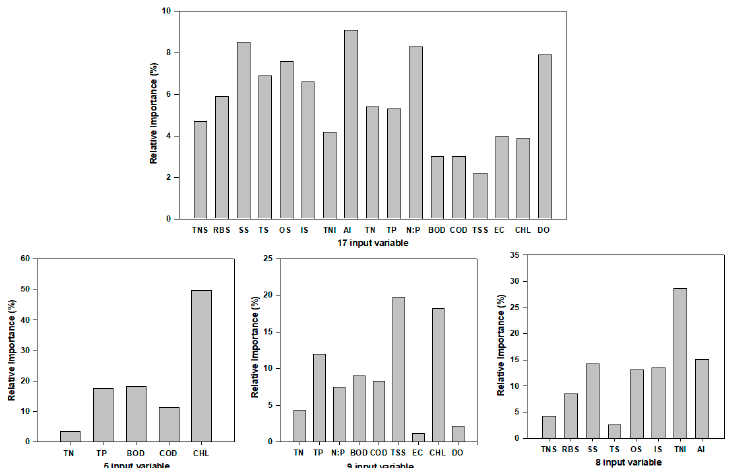
Figure 11. Variable importance in ANN to predict IBI model (TN—total nitrogen, TP—total phosphorus, N:P ratios, BOD—biological oxygen demand, COD—chemical oxygen demand, TSS—total suspended solids, EC—electrical conductivity, CHL—chlorophyll, DO—dissolved oxygen, TNS—total native fish species, RBS—ri ffl e benthic species, SS—sensitive species, TS—tolerant species, IS—intermediate species, TNI—total number of individuals,